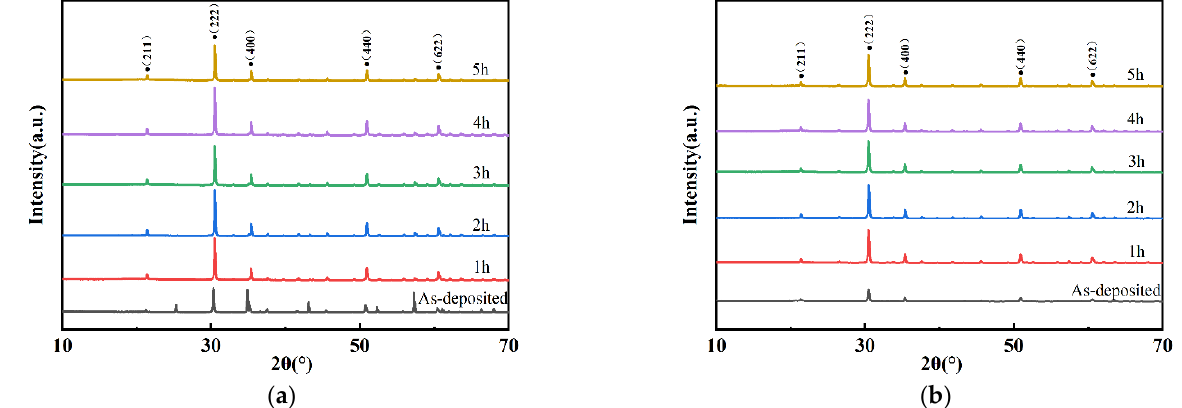
Figure 3. XRD patterns of films annealed for different annealing times: ( a ) ITO; ( b ) In 2 O 3 .